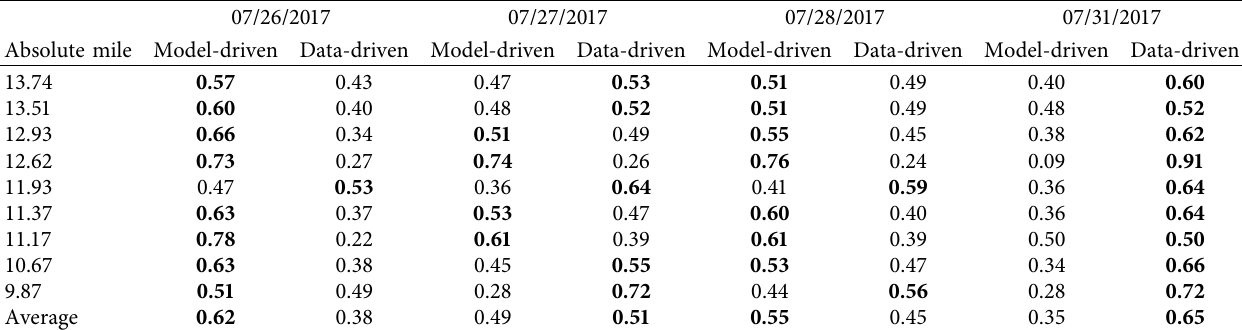
Table 8: Compare account for estimation between model-driven and data-driven in all-day.